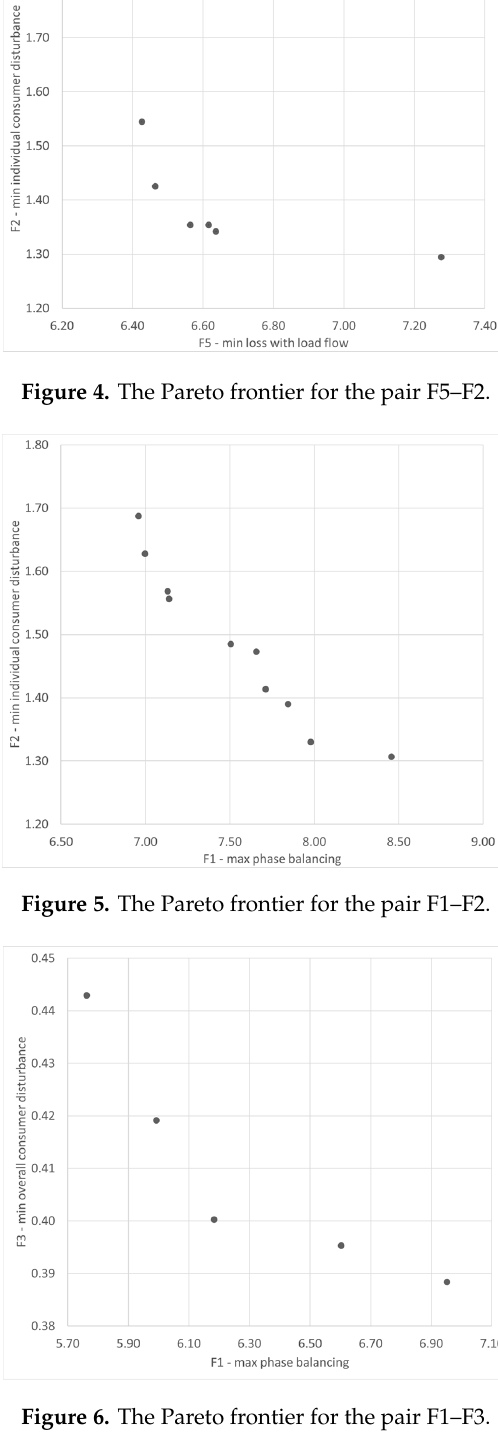
Figure 7. The Pareto frontier for the pair F5–F4. . Figure 8. The Pareto frontier for the pair F1–F5. Table 6. Fitness functions for the pair F5 ‐ F2 Solution No.